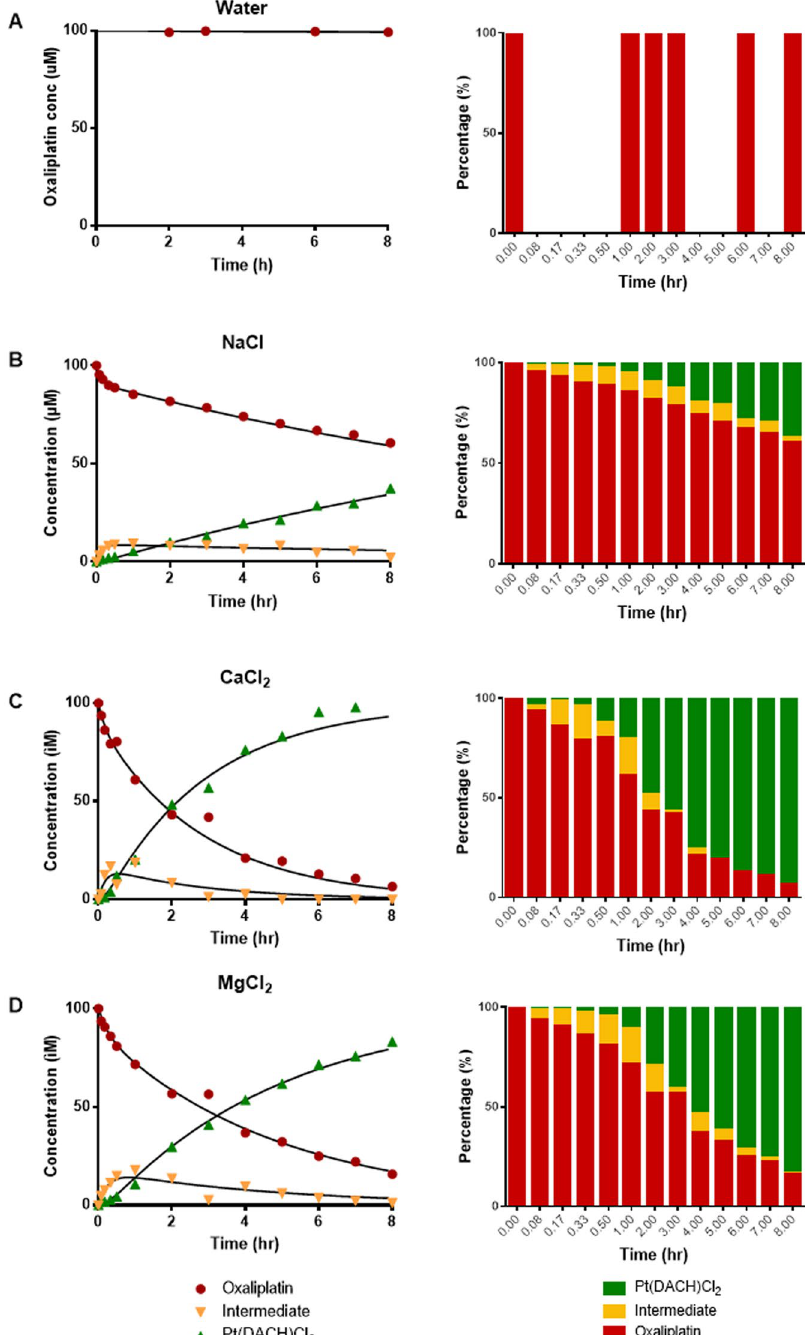
Figure 2. Time-course and mass balance analysis of oxaliplatin degradation in ( A ) water, ( B ) 150 mM NaCl, ( C ) 75 mM CaCl accelerated in the presence of calcium and magnesium. Red: Intact oxaliplatin. Yellow: intermediate. Green: Pt(DACH)Cl 2 . Data points represent the mean of independent replicate measured values. The lines represent kinetic models shown in the text whose rate constants are shown in Table